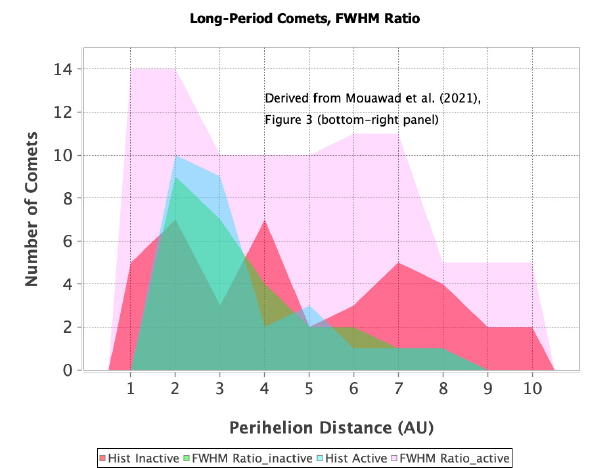
Figure 4. Example area chart made by Thoth. An area chart is similar to a line chart in that it has categories instead of numbers on the domain axis (Figure 13 in Paper I gives a line-chart example). In this example, the categories are number labels. The difference between the two graph types, however, is that area charts have coloring or shading under their curves, and the curve outlines are not drawn so as to emphasize the area under each curve.